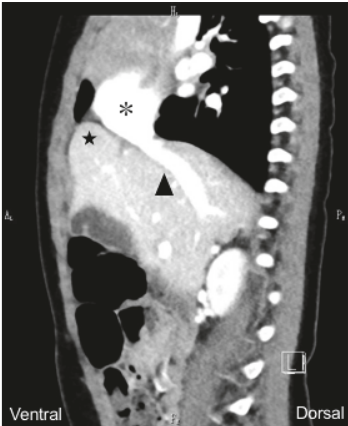
Figure 2: Abdominal computed tomography at 1 year of age. A Morgagni hernia (black star) can be seen, and the right atrium (asterisk) and inferior vena cava (arrowhead) are displaced on the ventral